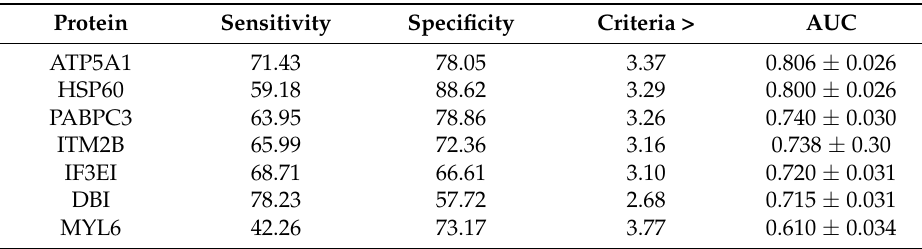
Figure 1. Representative images of a high-risk malignant (HR) and low-risk malignant (LR) prostate cancer tissue core (0.6 mm diameter) taken from sister sections of a tissue array block. Tissue array sections were stained using a 3,3-diaminobenzidine (DAB) protocol for the following proteins (ATP synthase F1 subunit 1 (ATP5A1), Diazepam-binding inhibitor (DBI), 60 kDa Heat Shock Protein (HSP60), IF3EI, Integral Membrane Protein 2B (ITM2B), Myosin Light Chain 6 (MYL6), and Polyadenylate-binding protein 3 (PABPC3)). Table 3. Evaluation of seven putative biomarkers.